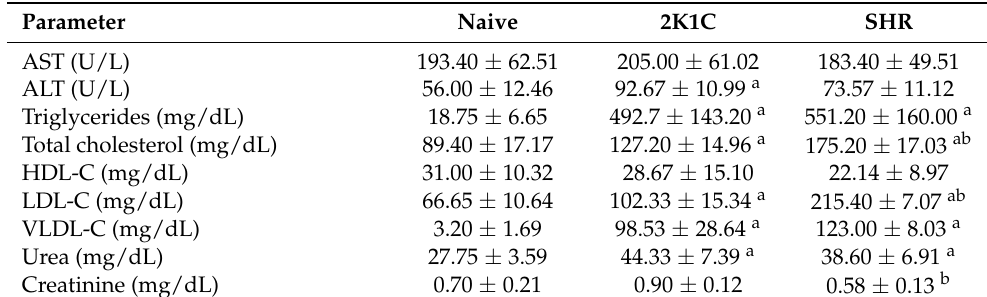
Table 5. Biochemical parameters of the different experimental groups at the end of 6 weeks of treatment with the high-fat